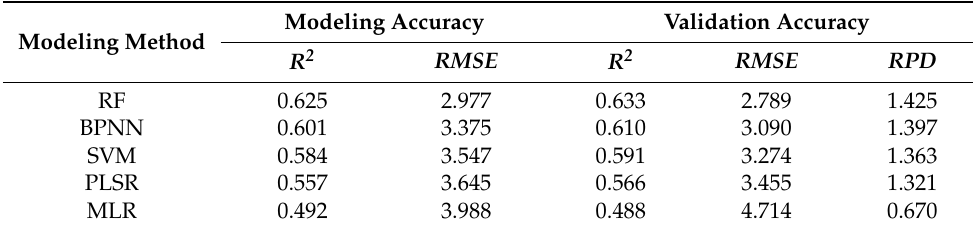
Table 8. Accuracy statistics of the NDVI based retrieval